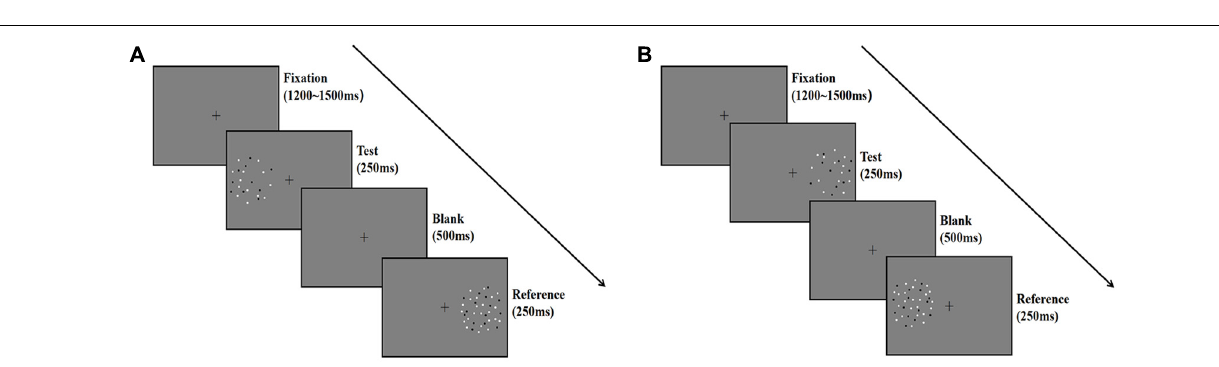
FIGURE 1 | The stimuli used in Experiment 1. Reference in the random and the regular conditions are shown. Reference and test patterns were displayed successively in the hemifield. Therefore, the paths on the other side were blank. The positions of references and tests were counterbalanced across participants.